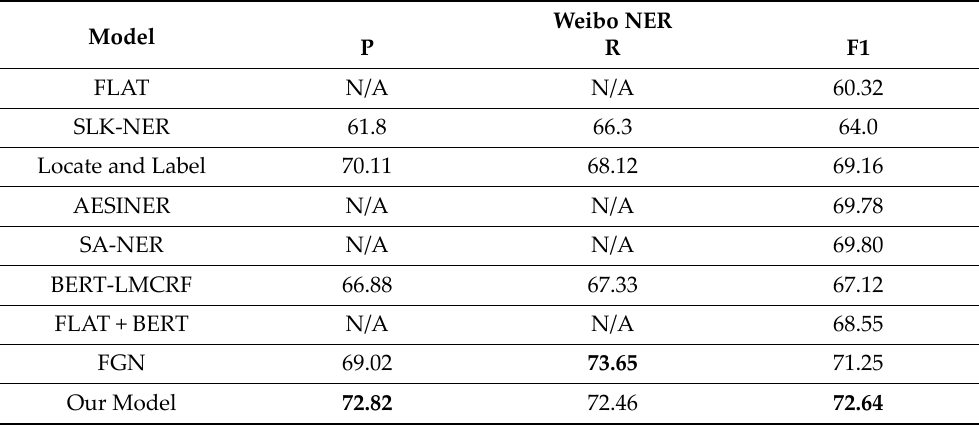
Table 3. Detailed statistics of our model on Weibo NER.